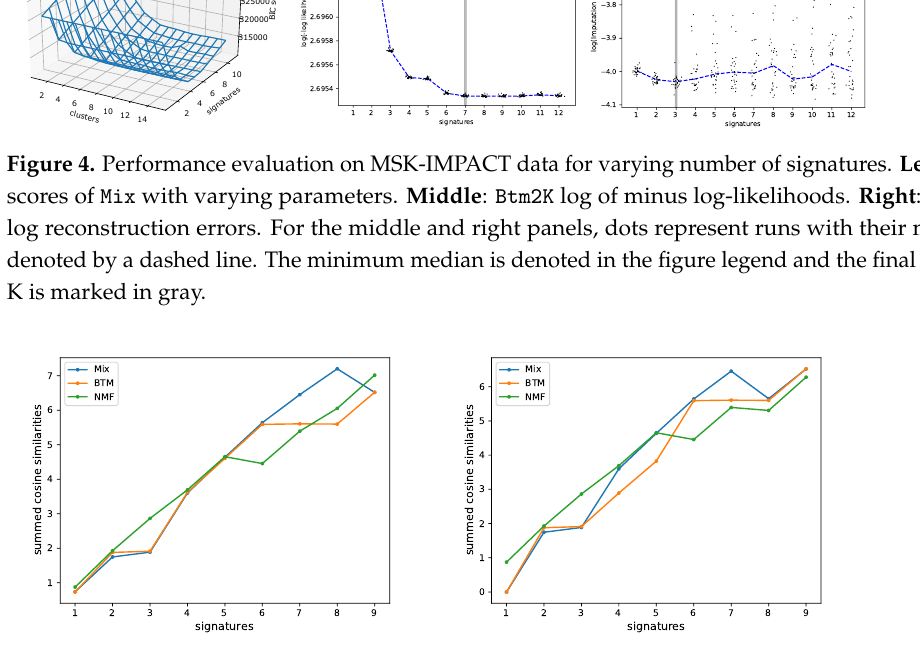
Figure 5. Summed cosine similarities of de novo signatures and COSMIC signatures. In the summa- tion, only unique signatures with similarity above 0.7 ( left ) or 0.8 ( right ) were considered.